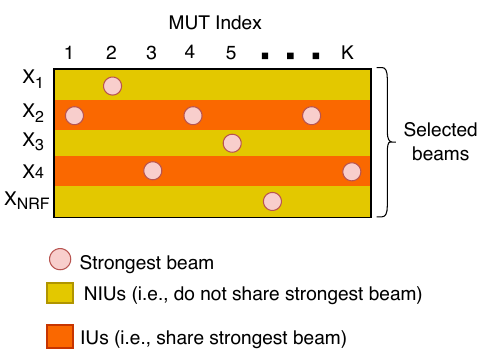
Figure 2. Illustration of the IUs and NIUs produced by beam selection.